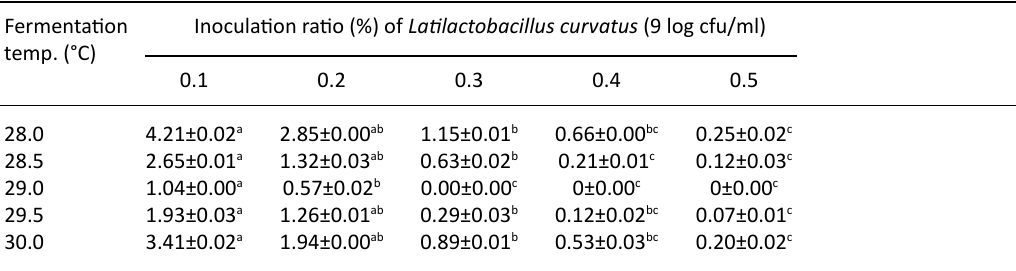
Table 1. Survival of Staphylococcus aureus (log cfu/g) in the pickled shrimp affected by inoculation ratio (%) of Latilactobacillus curvatus (9 log cfu/ml) and fermentation temperature (oC) after 6 weeks of fermentation Fermentation